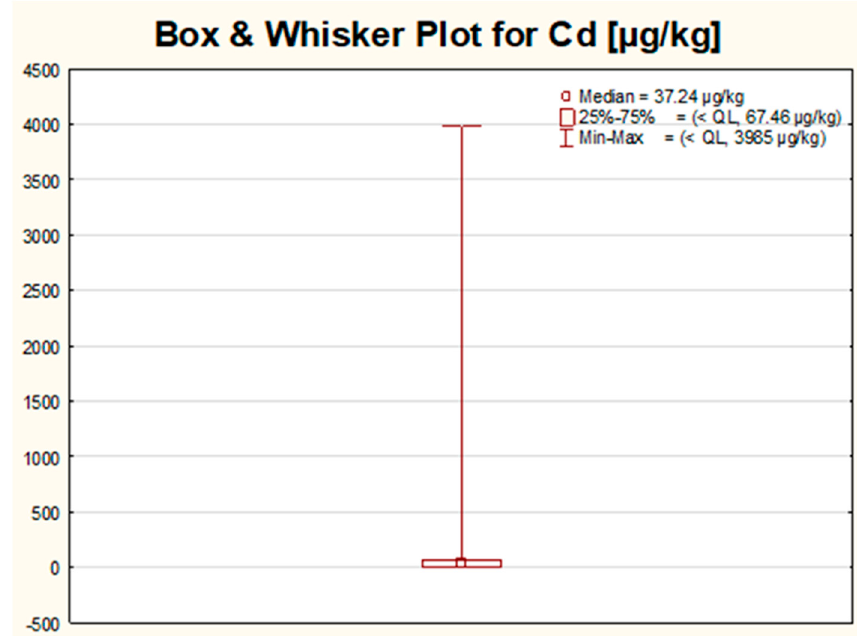
Figure 1. The box–whisker plots for Cd concentrations in the studied eye shadows (µg/kg).